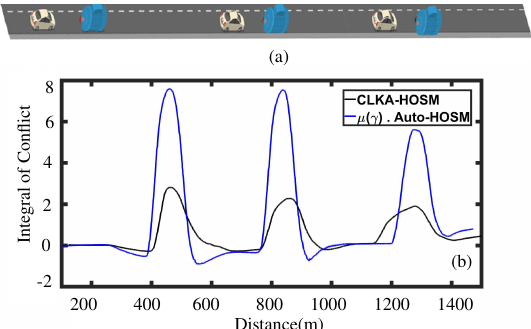
Figure 9. ( a ) The obstacle avoidance scenario; ( b ) comparison between the LKA controller weighted with the LOA function and the CLKA-HOSM controller for the minimization of the conflict for an obstacle avoidance scenario using a metric Integral of Conflict.